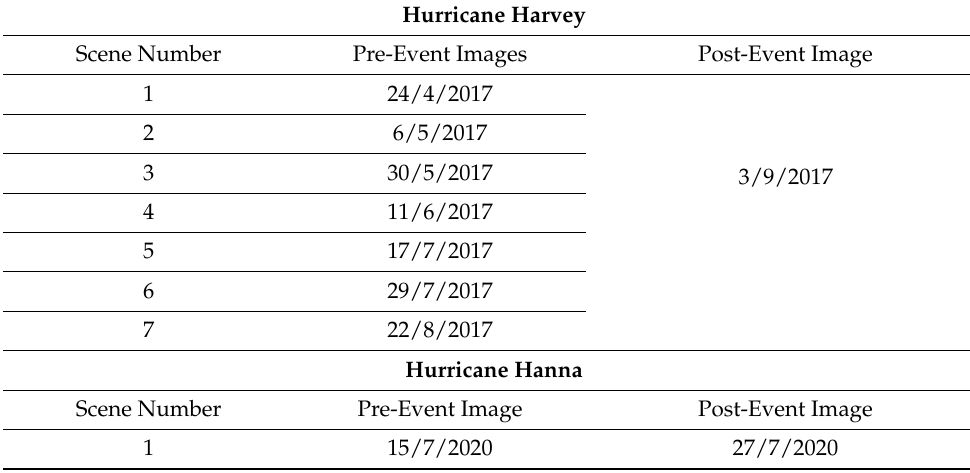
Table A3. List of SAR scenes used for flood